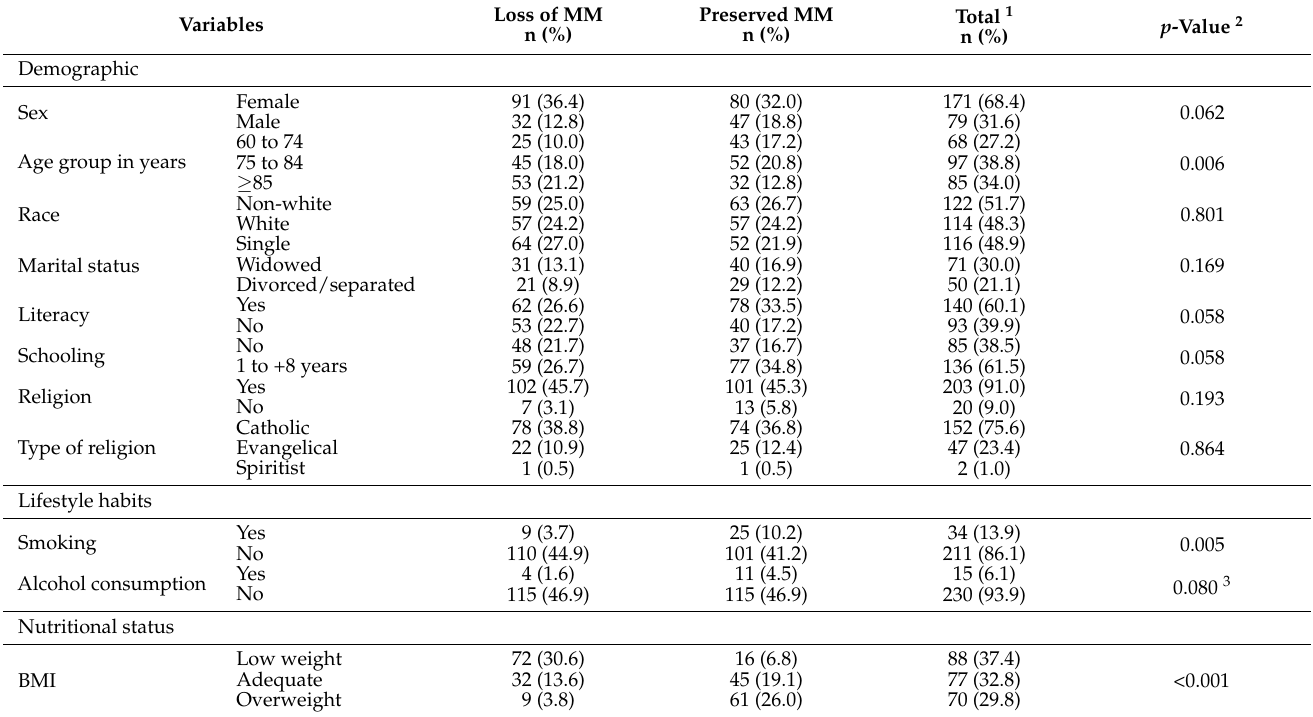
Table 1. Sociodemographic characterization, lifestyle habits, and nutritional status and their associa- tion with the muscle mass of older adults living in LTCF. Natal, RN, Brazil, 2021.